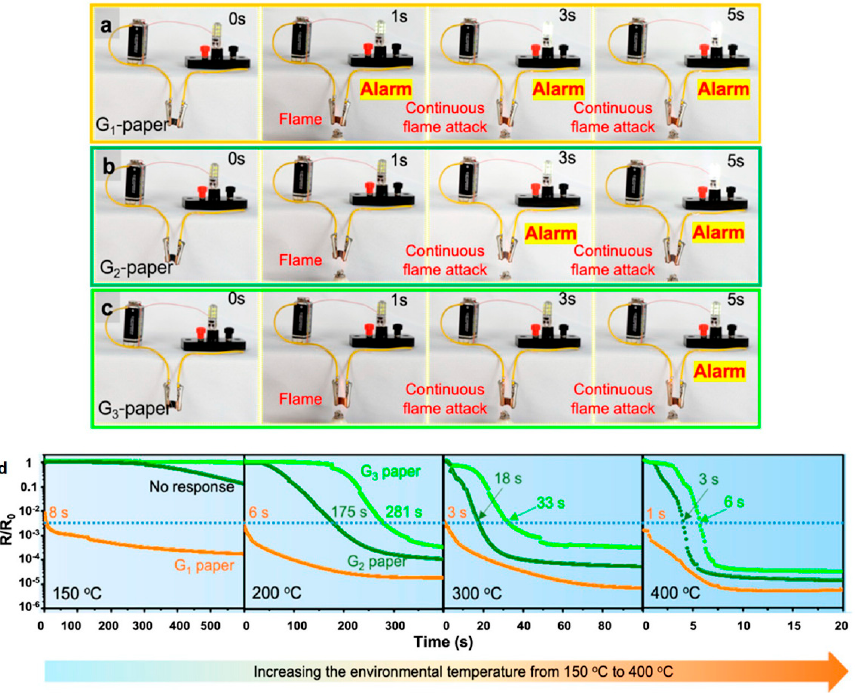
Figure 6. Fire-warning response behavior of PEG/GONR/MMT nanocomposite papers: ( a – c ) flame- detection response of G 1 , G 2 , and G 3 nanocomposite papers; ( d ) resistance change of the nanocom- posite papers under different temperature values, from 150 °C to 400 °C.